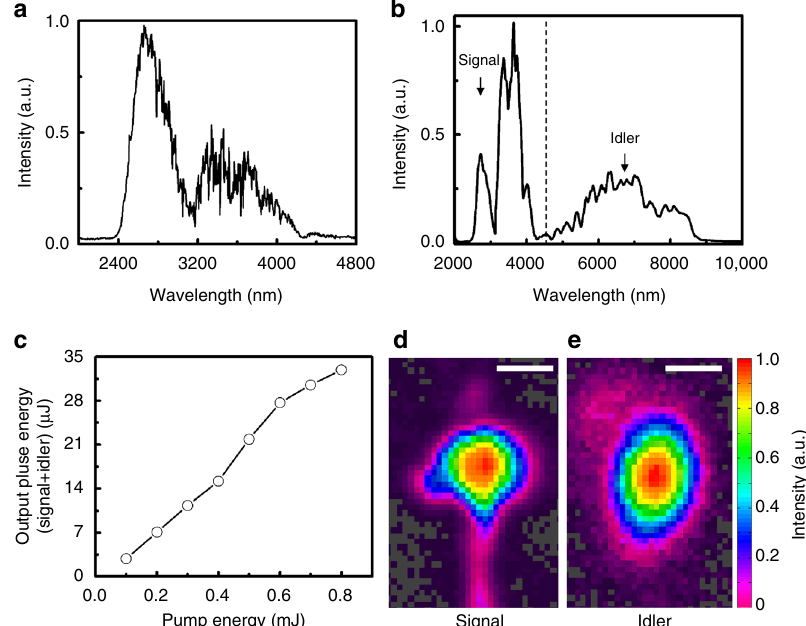
Fig. 2 Mid-infrared optical parametric ampli fi er with broad bandwidth and high energy. a The signal spectrum from white-light generation at BaF 2 , measured after a 2400 nm long-pass fi lter. b The measured output spectrum of the mid-infrared optical parametric ampli fi er (mid-IR OPA). The dotted line separates the signal and idler spectra. c The output pulse energy of the mid-IR OPA vs. pump energy. The solid line connects the measured points to guide the eye. The far- fi eld beam pro fi le of the ampli fi ed signal and idler is presented in d and e , respectively. The white bars represent a scale of 1